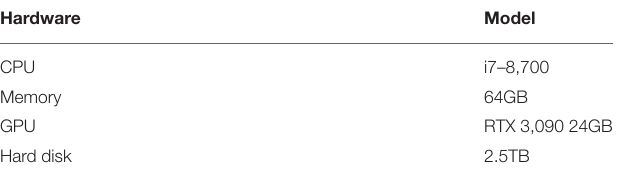
TABLE 3 | Configuration of experimental environment.